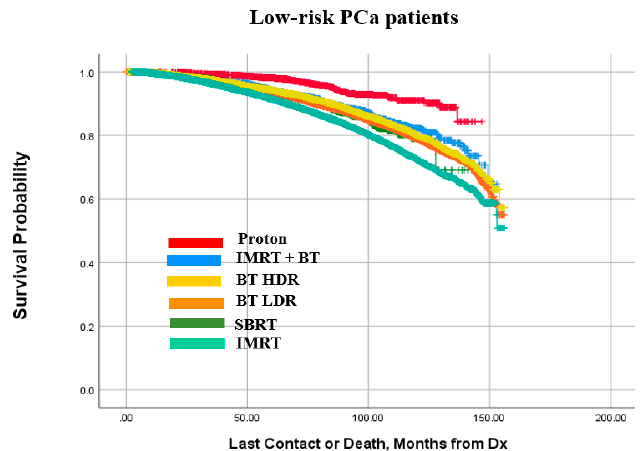
Figure 5. Kaplan–Meier curve for cumulative survival of low-risk patient prostate cancer (PCa) patients treated with the compared modalities.